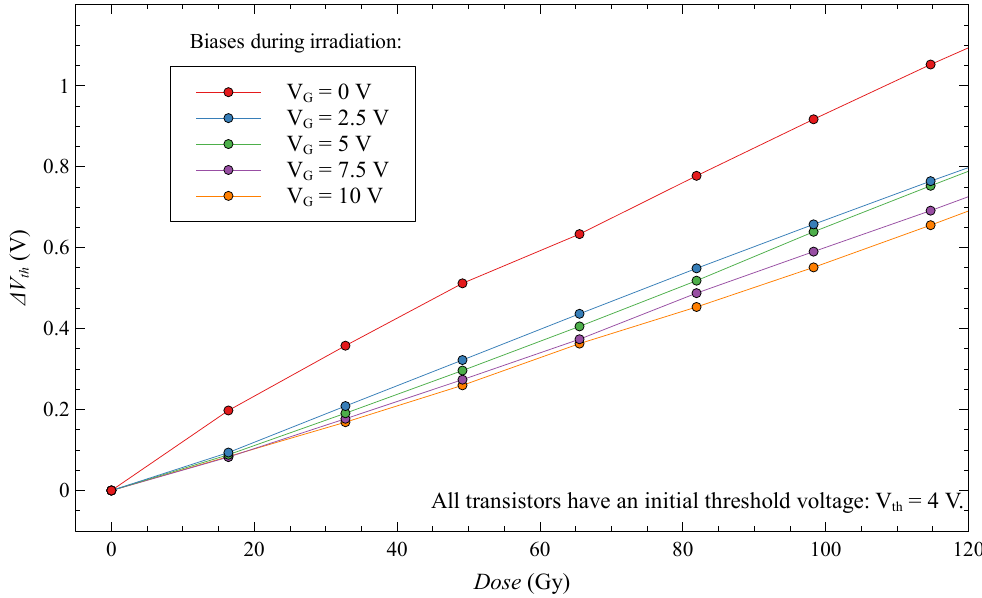
Figure 23. Interesting phenomenon of higher sensitivity with zero-biased floating-gate MOS